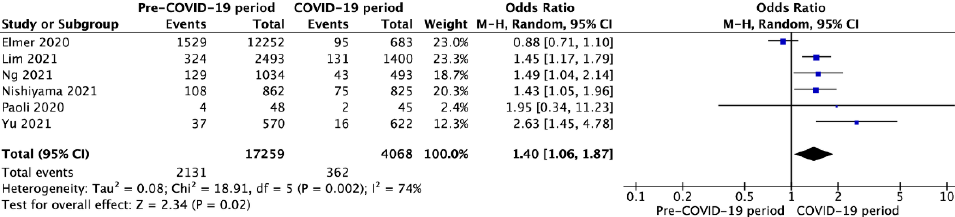
Figure 4. Forest plot prehospital return of spontaneous circulation in pre- vs. intra-COVID-19 periods. The center of each square represents the odds ratios for individual trials, and the corresponding horizontal line stands for a 95% confidence interval. The diamonds represent pooled results. Legend: CI = confidence interval; OR = odds ratio.